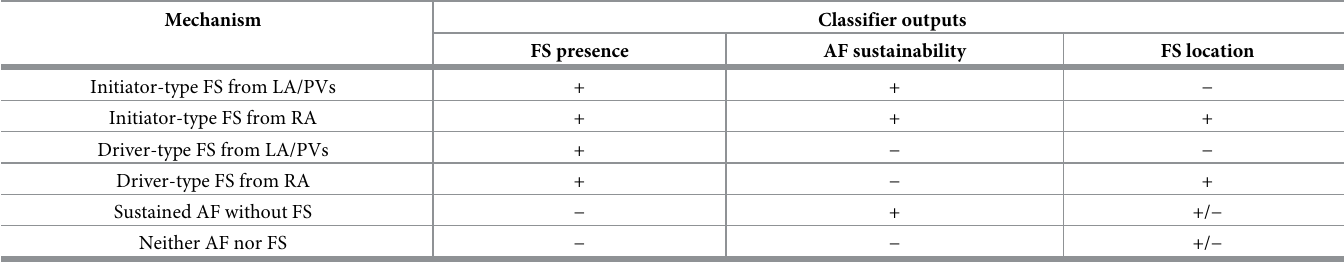
Table 4. Computation of signal-level mechanisms from the positive (“+”) or negative (“ − ”) prediction outputs of our classifiers. Note that FS location classifier out- puts whether the FS is on RA. Mechanism Classifier outputs FS presence AF sustainability FS